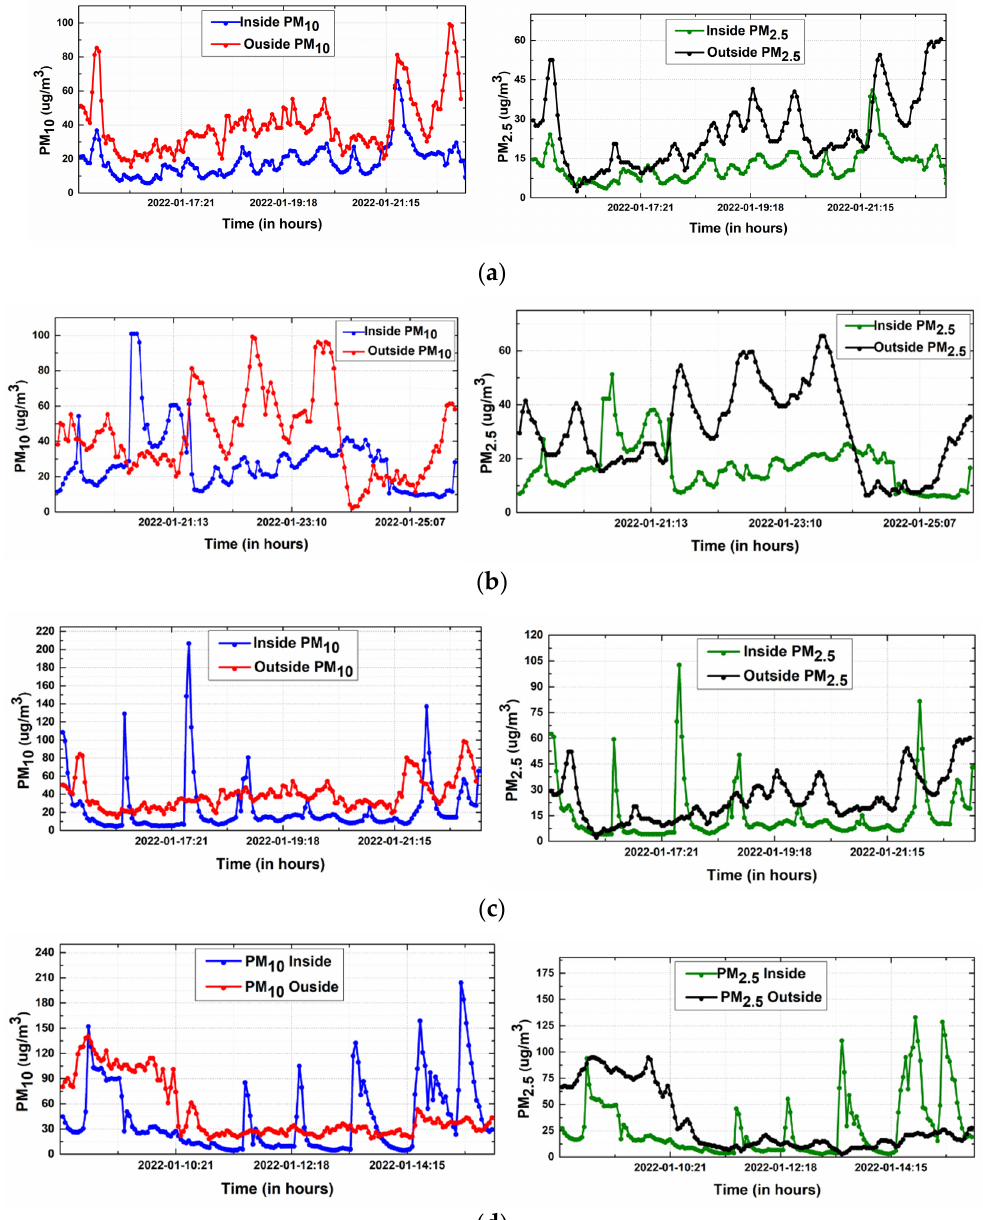
Figure 3. Average PM 2.5 and PM 10 concentrations for Different Apartments (APTI–APTIV): In- door and Outdoor Diurnal Variations. ( a ) Apartment with indoor plants and ventilation (APTI). ( b ) Apartment with indoor plants (only CAM plants) and without ventilation (APT II). ( c ) Apartment with ventilation and without indoor plants (APT III). ( d ) Apartment without ventilation and indoor plants